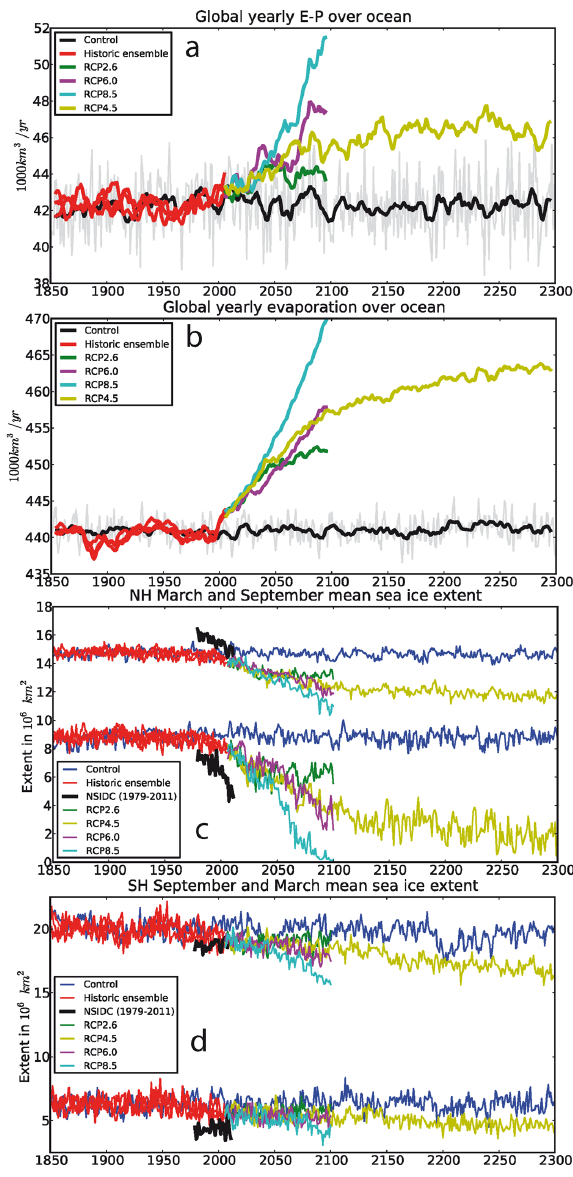
Fig. 9. Decadal moving average annual evaporation minus precip- itation (a) and evaporation (b) from the oceans, and the northern (c) and southern hemispheric (d) March and September sea-ice ex- tent during the NorESM1-M simulations for 1850 to 2300. Black in (a) and (b) and blue in (c) and (d) : the piControl, red: 1850–2005 Historic1, 2, and 3; dark green: RCP2.6 2005–2100; light green: RCP4.5 2005–2300; magenta: RCP 6.0 2005–2100; cyan: RCP8.5 2005–2100. Black curves in (c) and (d) are sea-ice extents estimated from observations (NSIDC, Fetterer et al.,